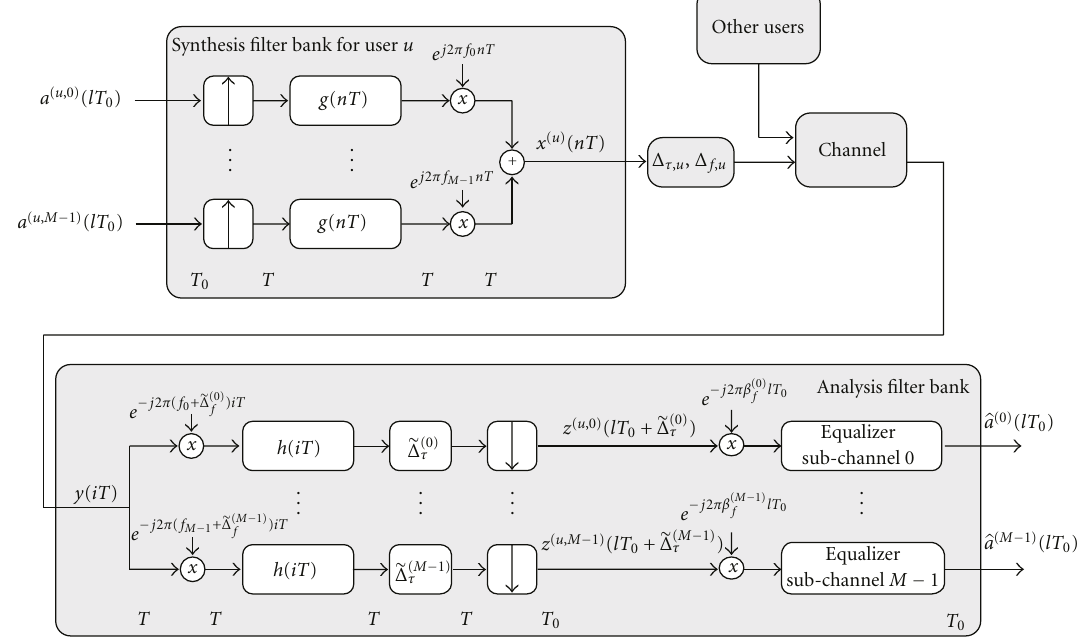
Figure 1: Filter bank system model with time/frequency compensation at subchannel